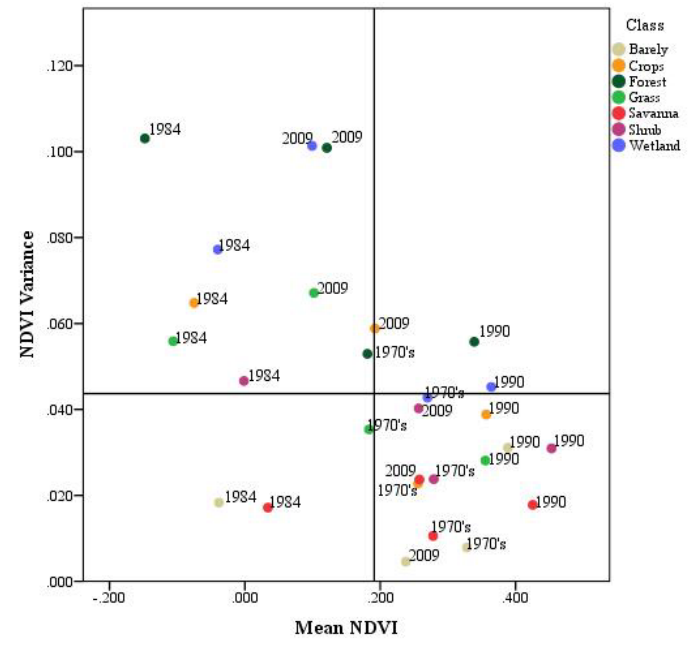
Figure 7. Results for mean variance analysis for each land cover class (barren/barely vegetated, croplands, wetlands, grasslands, savannas, shrub lands, forest) from the IGBP land cover classes.